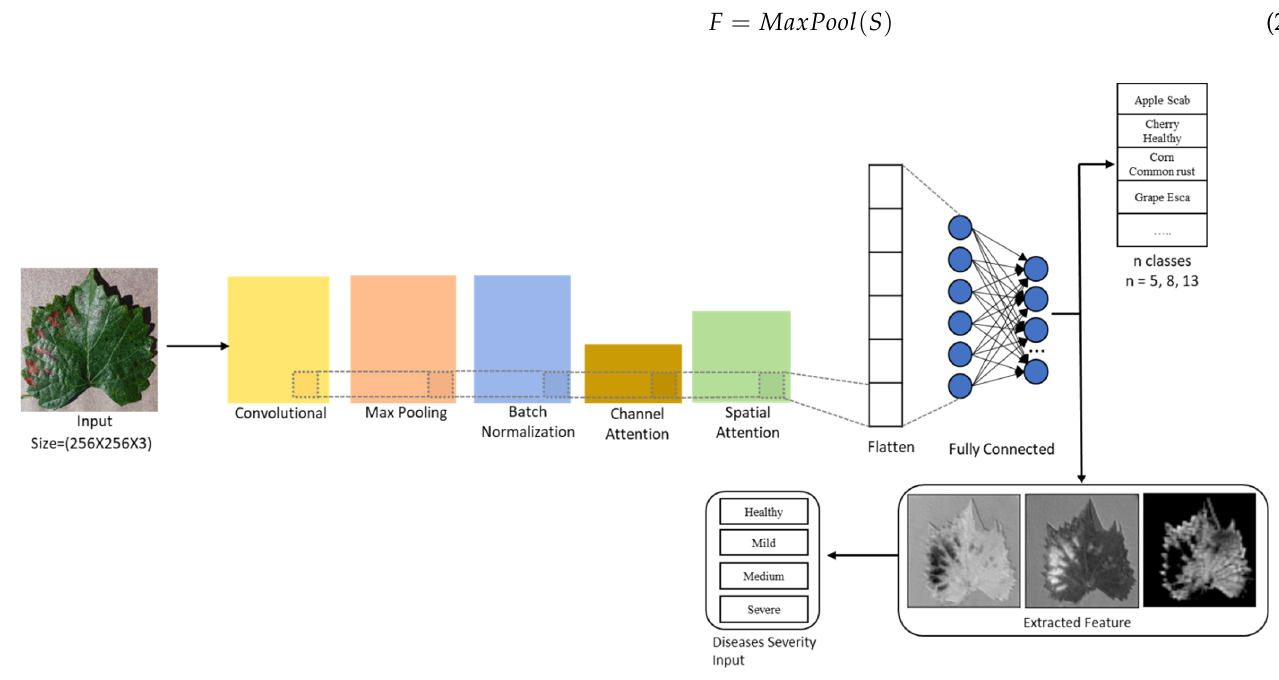
Figure 2. Visual architecture of proposed model.